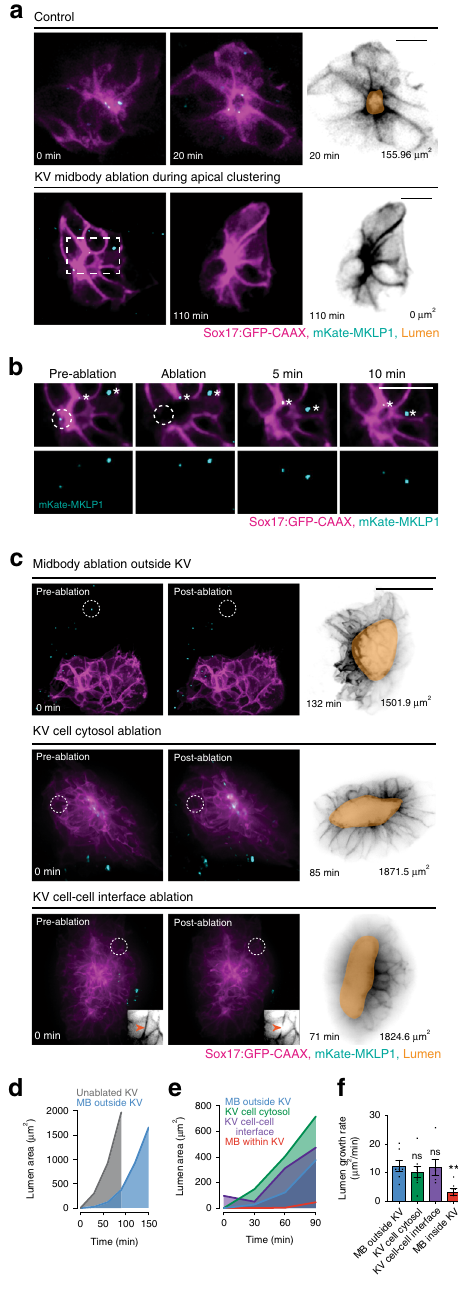
Fig. 4 Premature cleavage of the cytokinetic bridge via laser ablation results in disrupted lumen formation. a Top: unablated control embryo during apical clustering (left) and lumen formation (center, right). Bottom: central KV midbody ablated during apical clustering from experimental ablation group (left). Subsequent failed lumen formation shown (center, right). KV membrane (Sox17:GFP-CAAX, magenta) and midbody marker (mKate-MKLP1, cyan) shown in the left and center panels; KV membrane (Sox17:GFP-CAAX, gray) and lumen trace (orange) shown on the right. Bar, 20 μ m. b Midbody ablated in a . Pre-ablation, immediately post ablation, and at 5 and 10 min post ablation shown. KV cell membrane (Sox17:GFP-CAAX, magenta) and midbodies (mKate-MKLP1, cyan) shown. Additional unablated midbodies depicted with asterisks. Bar, 10 μ m. c Representative 3D renderings of KV pre-ablation (left), immediately post ablation (center), and after lumen formation (right) in control groups. Ablation control conditions shown: midbody ablation outside KV (top), KV cell cytosol ablation (middle), KV cell – cell interface ablation (bottom). KV membrane (Sox17:GFP-CAAX — magenta or grayscale), midbodies (mKate-MKLP1 — cyan), and lumen trace (orange) shown. Ablation location shown by dotted white circle. Grayscale inset in bottom panel depicts ablation at cell – cell interface within KV (Sox17:GFP-CAAX). d , e Graphs depicting average lumen area over time for unablated (gray) embryos and embryos with midbody ablated outside KV (blue, d ), or for embryos with ablation at midbody outside KV (blue, e ), KV cell cytosol (green, e ), KV cell membrane (purple, e ), and midbody within KV (red, e ). Lumen areas averaged and binned every 30 min. f Bar graph depicting rate of lumen area expansion over time. Dots represent individual values. d – f n > 6 embryos/condition across n > 3 experiments. ANOVA with Dunnett ’ s multiple comparison test completed for d – f compared with embryos with midbody ablated outside KV (blue). Mean displayed± SEM ( f ). Statistical results detailed in Supplementary Table